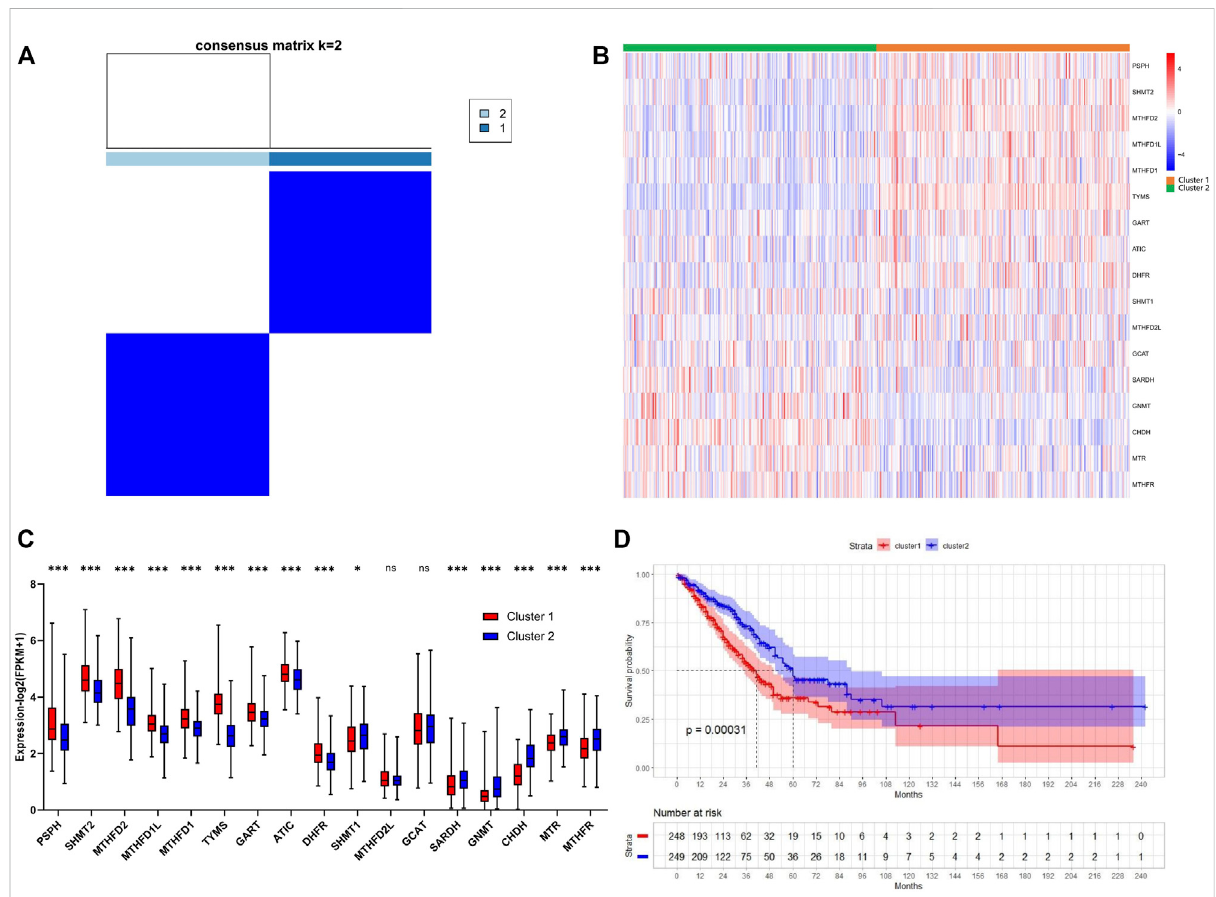
FIGURE 3 Consensusclusteringforone-carbonmetabolismassociatedgenesinLUADpatients. (A) Theconsensusmatrixshowspatientswithtwodistinct one-carbon metabolism statuses; (B) Heatmap of one-carbon metabolism associated genes expression level in two clusters; (C) The expression difference of one-carbon metabolism associated genes in two clusters; (D) Kaplan-Meier curves for overall survival in two clusters (Log-rank test).